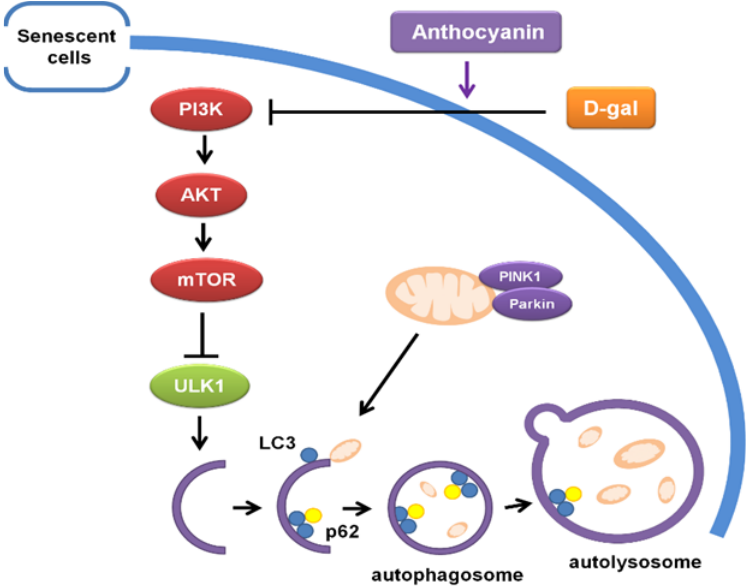
Figure 10. Proposed mechanism schema for Anthocyanin attenuates aging through clearing senescent cells by inducing apoptosis and autophagy via the inactivation of PI3K/AKT/mTOR pathway. Anthocyanin enhanced autophagic and mitophagic flux in senescent cells through inhibiting the activity of PI3K/AKT/mTOR pathway, clearing damaged organelles such as mitochondria, and promoted apoptosis of senescent cells to attenuate aging.